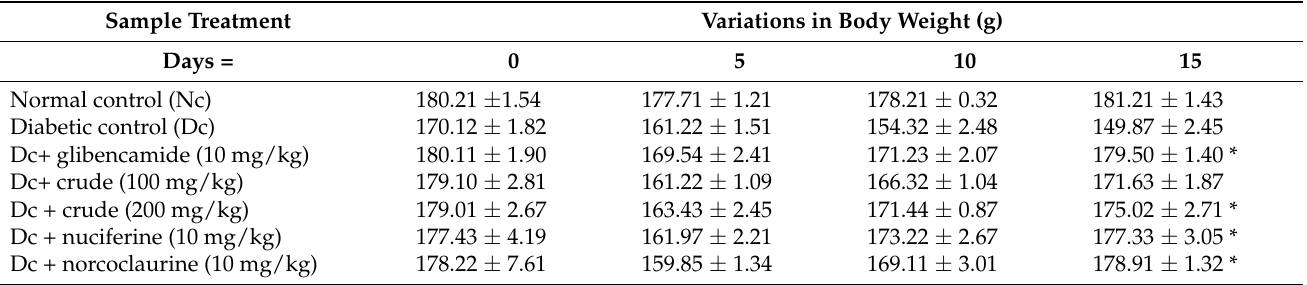
Table 2. Effect on body weights in diabetic rats by N. nucifera crude, nuciferine and norcoclaurine. Sample Treatment